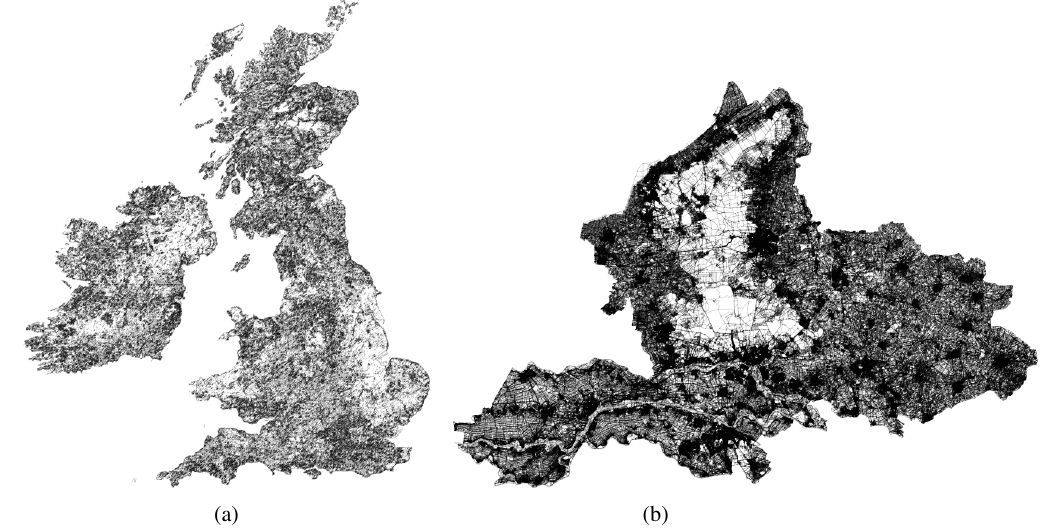
Figure 5: Two of the testing datasets: (a) CORINE and (b) cadastral